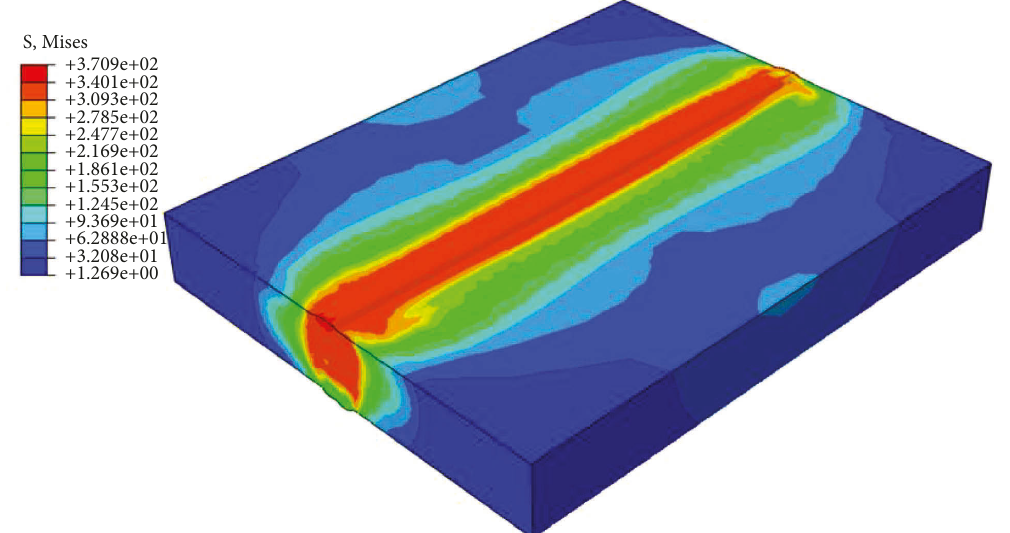
Figure 15: Residual stress (von-Mises) distribution (unit: